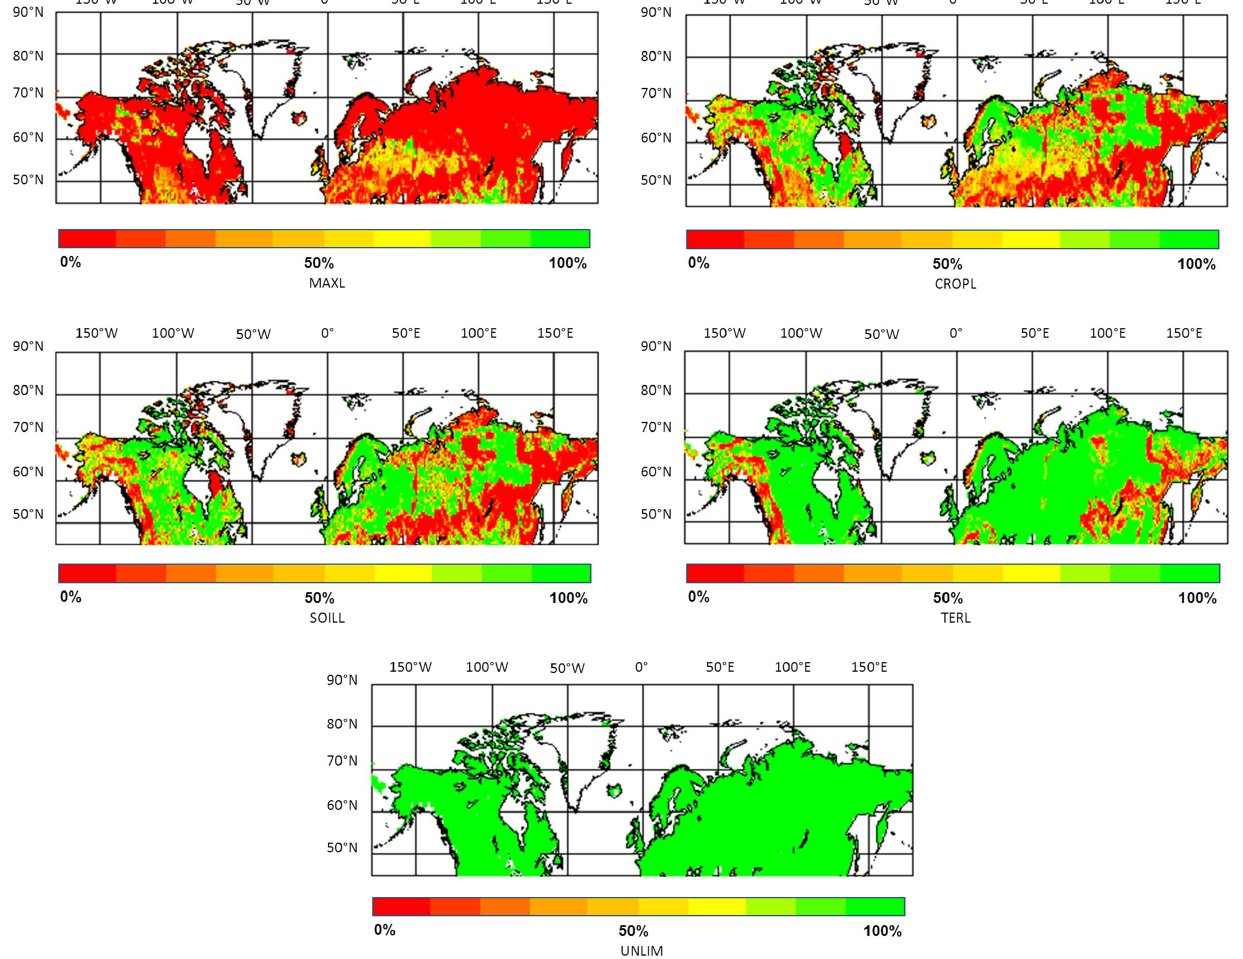
Fig. 4. Percentage of area (of each 0.5 ◦ × 0.5 ◦ grid cell) used for bioenergy crop plantations for land management scenarios (a) MAXL, (b) CROPL, (c) SOILL, (d) TERL, (e) UNLIM. Green symbolizes complete availability while red stands for unavailability of that grid cell for bioenergy crop